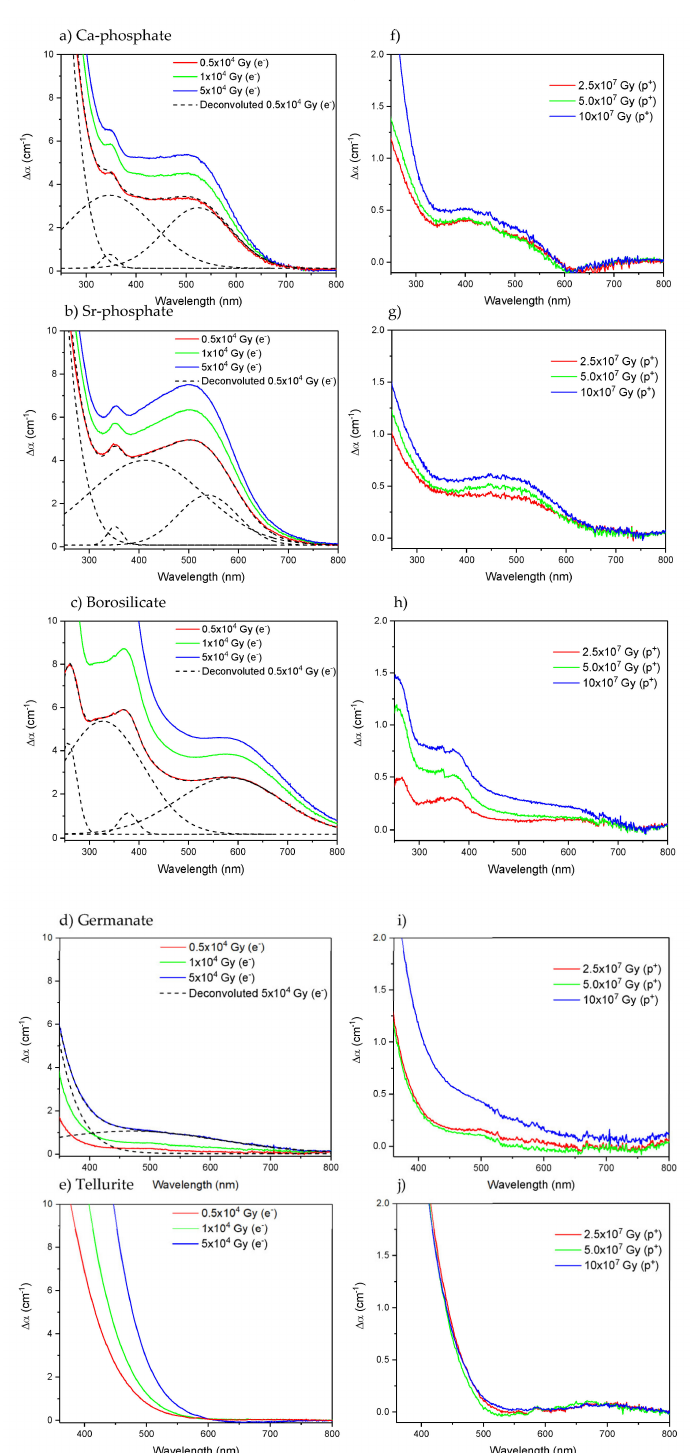
Figure 2. Subtracted absorption spectra prior to and after radiation treatment with electrons ( a – e ) and proton ( f – j ) of the Ca-phosphate, Sr-phosphate, borosilicate, germanate, and tellurite, respectively. ( a – d ) also include one deconvoluted spectrum from the